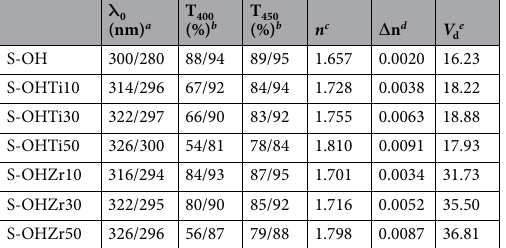
Table 2. Optical properties of S-OH and S-OH hybrid films with TiO 2 and ZrO 2 . a The cutoff wavelength (